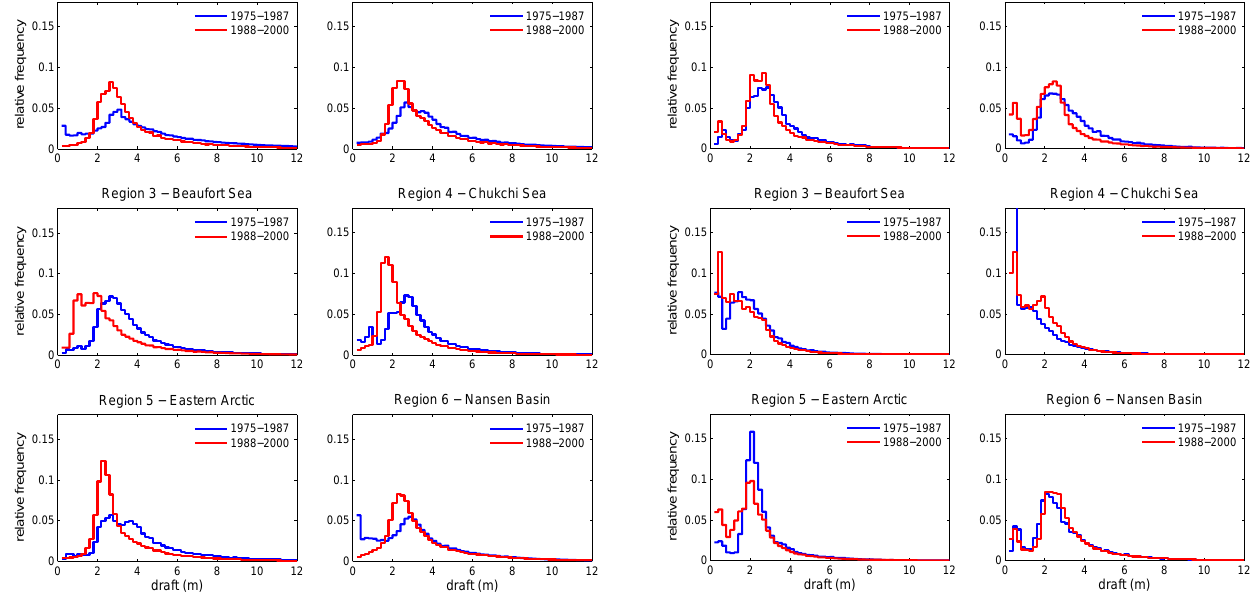
Fig. 3. Regional Spring draft distributions during periods 1975– 1987 (blue line) and 1988–2000 (red line). Bin width 0.2m.